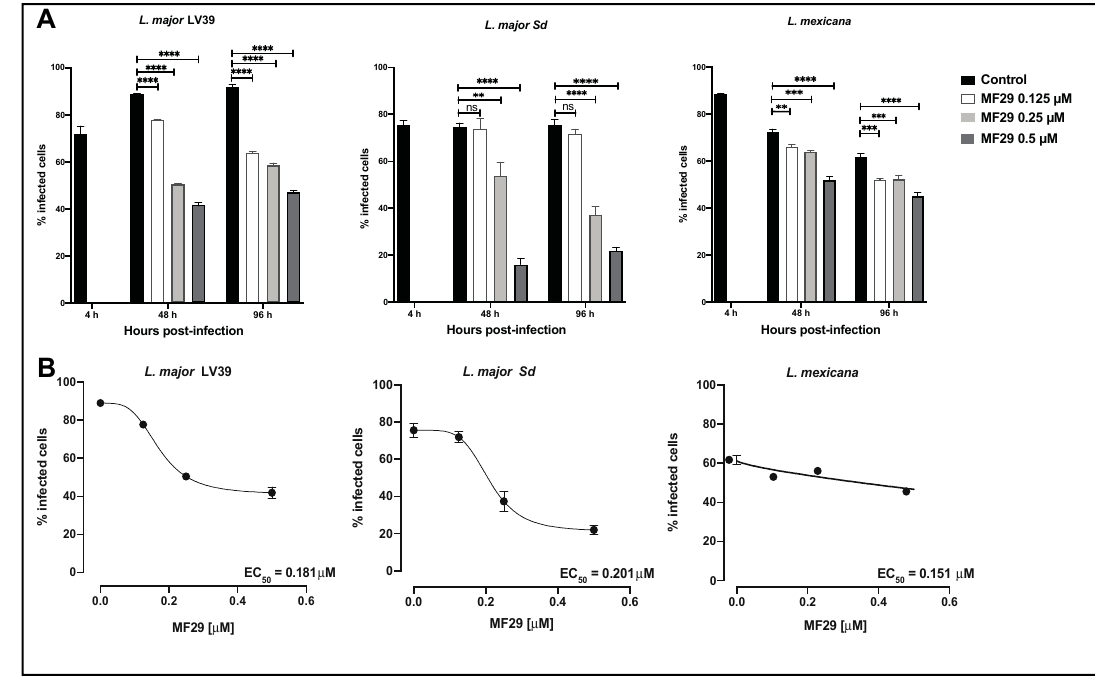
Figure 2. In vitro activity of MF29 against Leishmania -infected cells and EC 50 assessment. ( A ) BMDM were infected at a MOI 10 with L. major LV39, L. major Sd, and L. mexicana . As a control, another infection was performed for 4 h without further stimulation. The infected cells were incubated in presence of MF29 at a 0.5, 0.25, and 0.125 μ M concentration and at the time points of 48, and 96 h and the frequency of infected cells was analyzed ( B ). The EC 50 was determined with a non-linear regression by measuring the parasitic load at 96 h post-infection, in L. major LV39, L. major Sd, and L . mexicana -infected cells. Data are represented as mean ± SEM, n = 3 per group Two-Way ANOVA (Tukey’s post-hoc test). ** p < 0.001, *** p < 0.0002, **** p < 0.0001, ns = not significant.